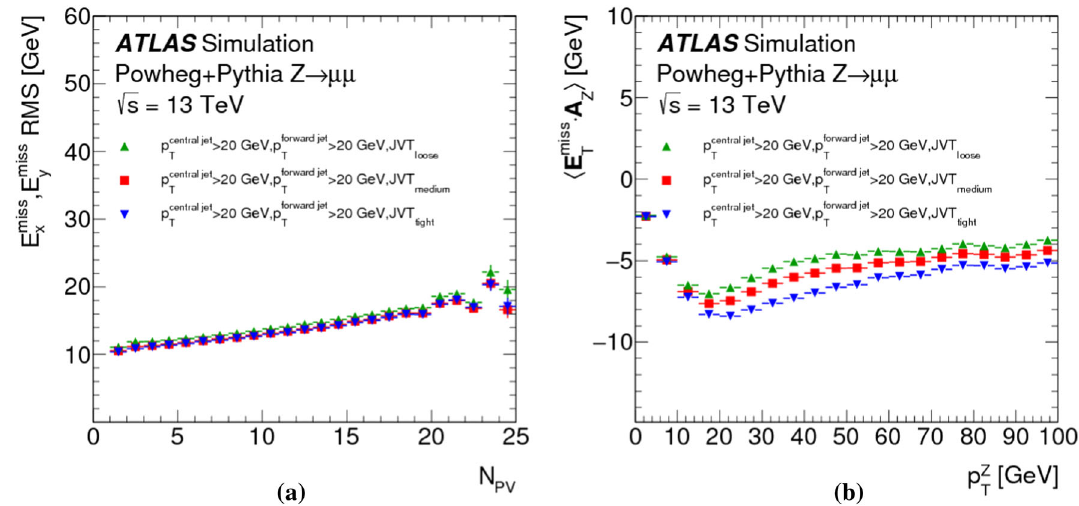
Fig. 17 E miss resolution and response for the different choices of JVT T discussedinthetext,asmeasuredfor Z → μμ eventsinMCsimulation. The a E miss resolution is shown as function of the pile-up activity mea- T sured by the number of primary vertices N PV , and the b E miss